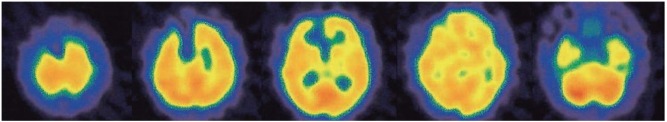
Mother's recently obtained 99mTc-ECD brain perfusion SPECT axial images.
Except for the absence of perfusion over the surgically resected area in the
right frontal lobe, brain perfusion is normal.